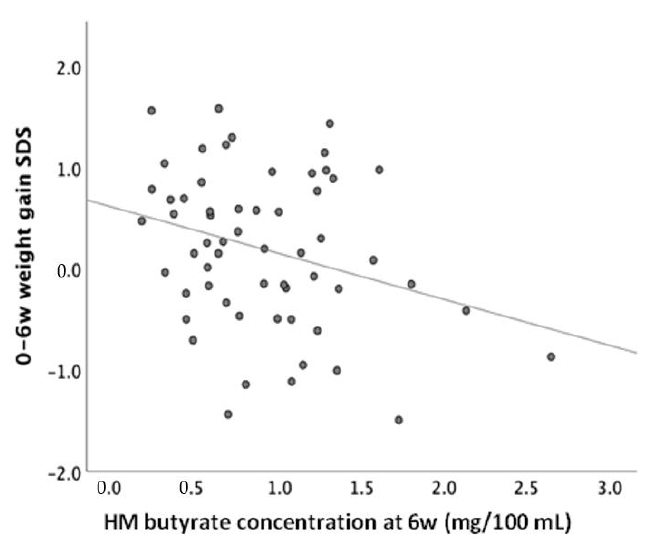
Figure 3. Negative association between HM butyrate level and early infant weight gain (0 − 6 weeks) ( p = 0.04). HM = human milk, SDS = standard deviation scores, w = weeks.